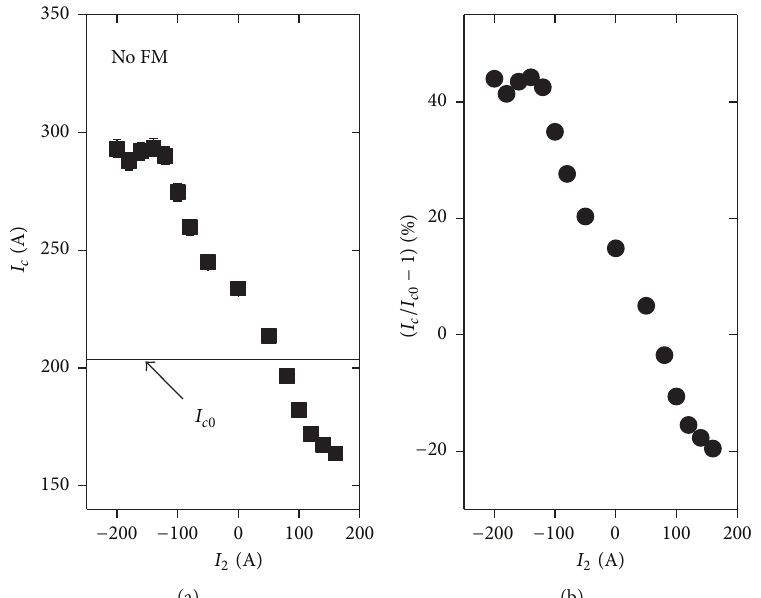
Figure5:(a) 𝐼 𝑐 versustheappliedcurrenttotheneighboringtapesand(b)increaseof 𝐼 𝑐 withrespecttotheneighboringcurrentforthree-layer stacked conductor without FM.